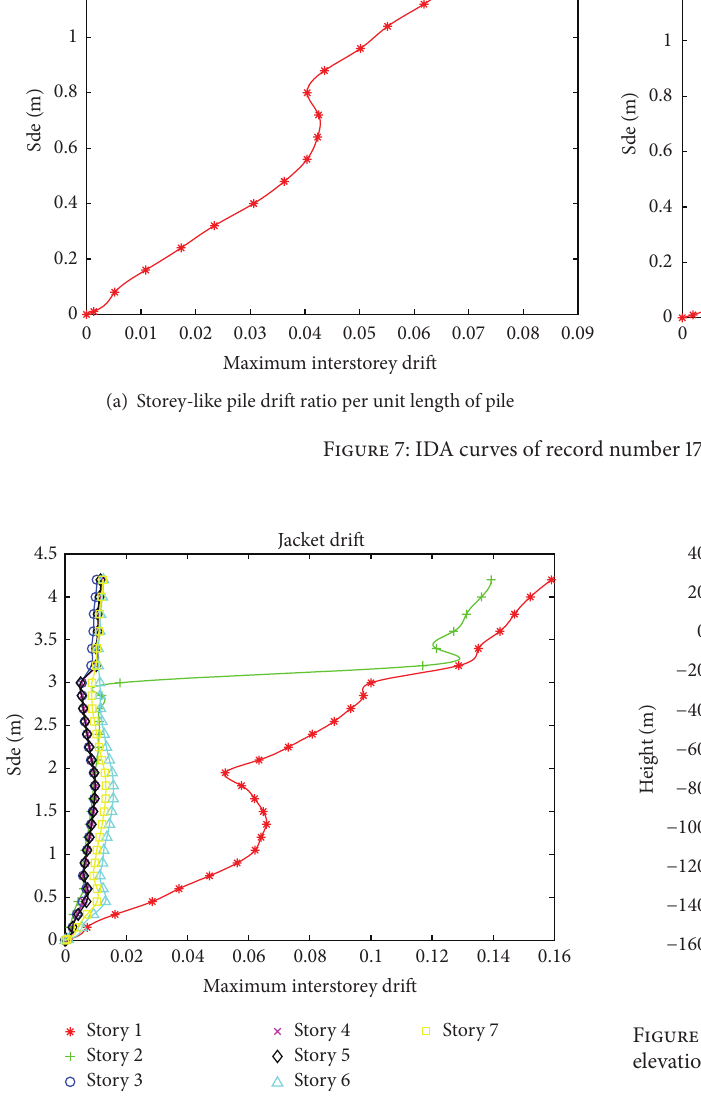
Figure 8: IDA curves of different storeys of the jacket part of PSP HE2 Platform.